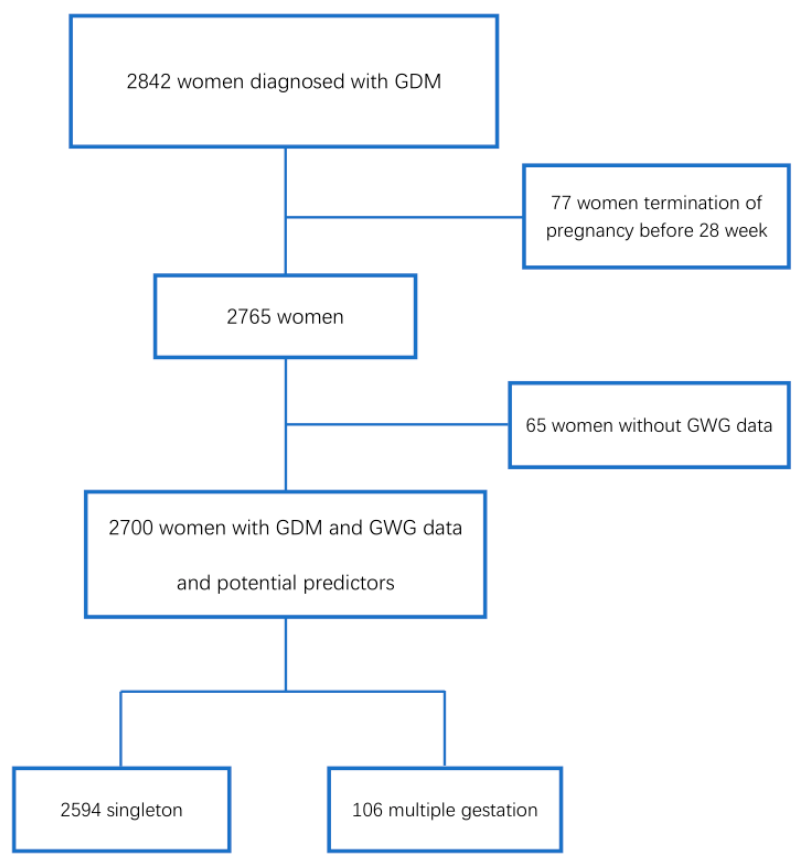
Figure 1. Flowchart of inclusion of patients in the study. GDM: Gestation Diabetes Mellitus. GWG: Gestational Weight Gain.